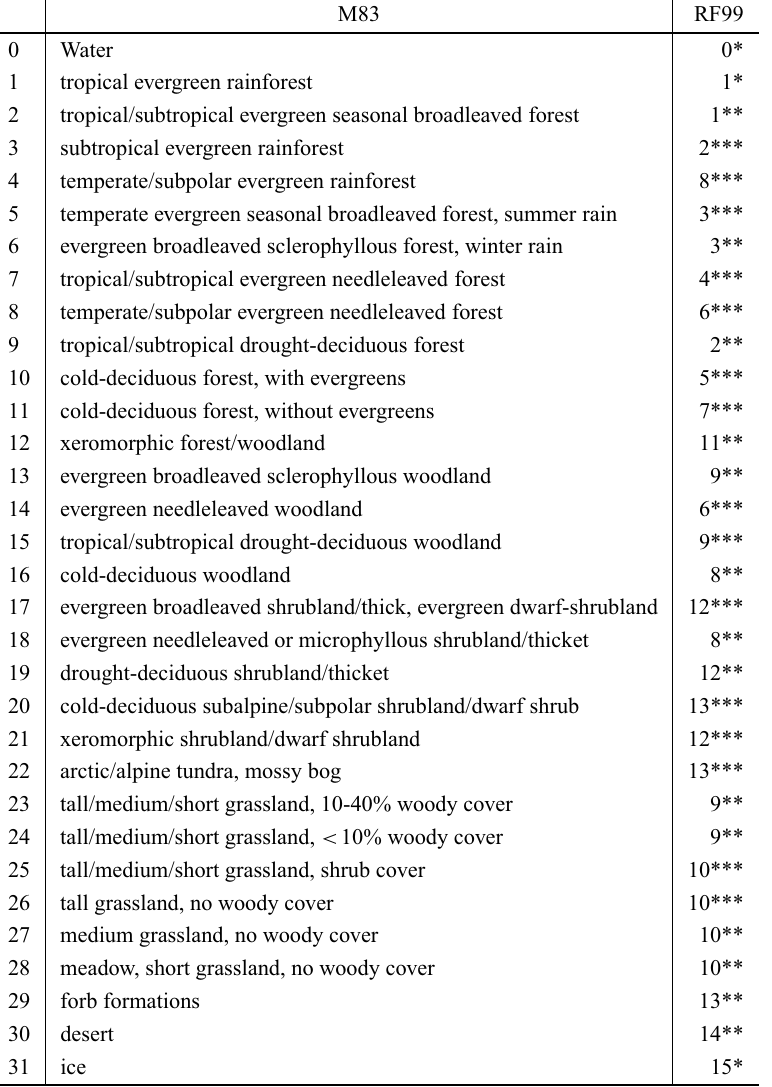
Relation between M83 and RF99 classifications. A * denotes conversion of M83 biome to one of RF99 when F iJ 1 ≥ 0 . 7 ; ** when 0 . 4 ≤ F iJ 1 ≤ 0 . 7 and F iJ 2 ≤ 0 . 2 ; and *** when it did not satisfied both of the two above criteria, then M83 biome i was subjectively associated with one of RF99 (see text for detailed explanation). RF99 vegetation type names are found in Table